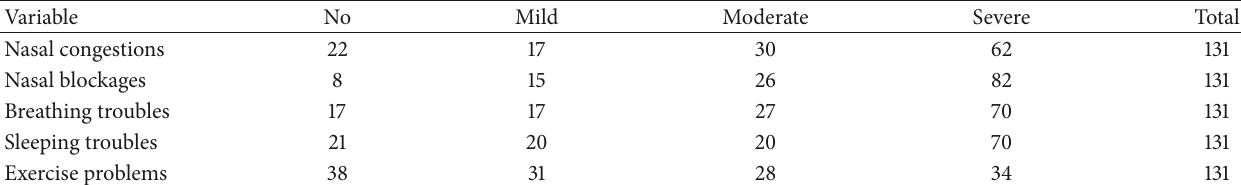
Table 2: Distribution of the study subjects by clinical presentations.